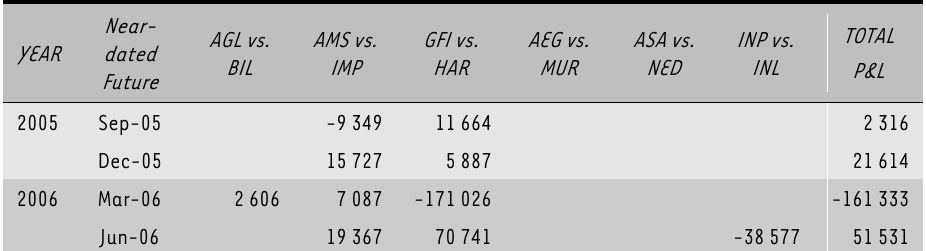
Profits and Losses from 2002 to 2008 resulting from the SSF trading strategy after all trading costs are taken into account for various stock